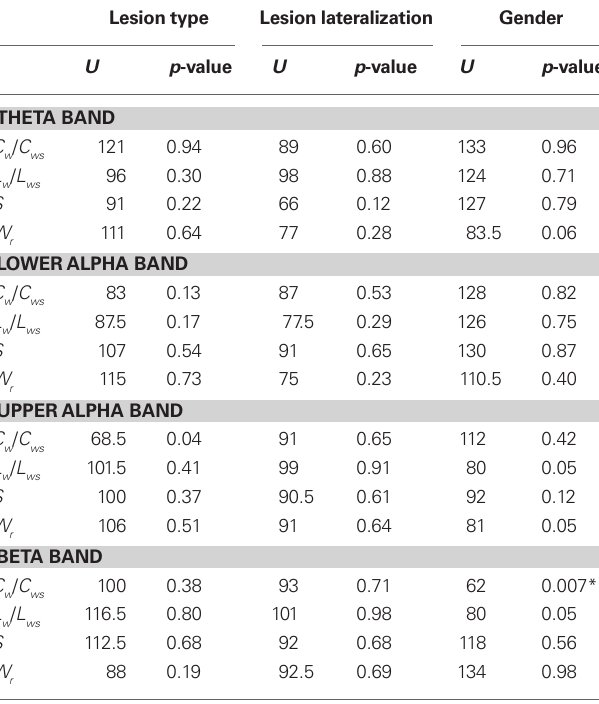
Table 3 | Correlations between memory performance after injection and (changes in) network characteristics.